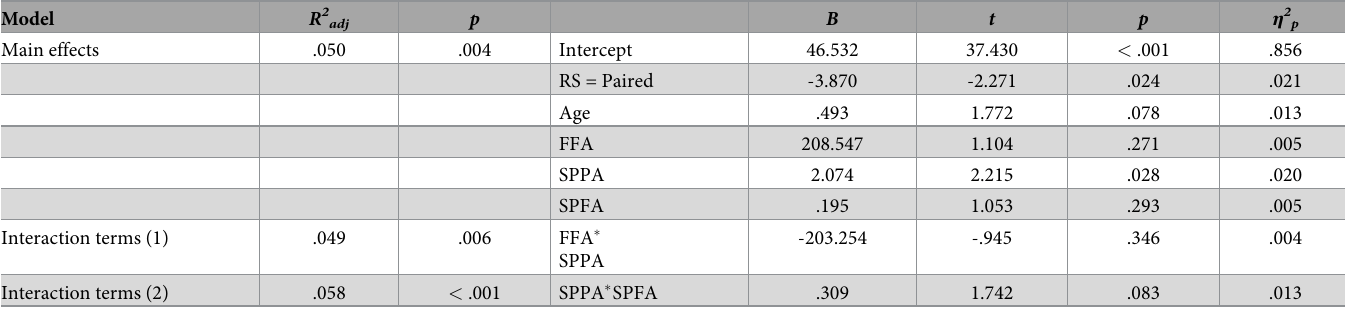
Table 3. General linear model for short-term sociosexual orientation considering the full data set (N = 242). Model